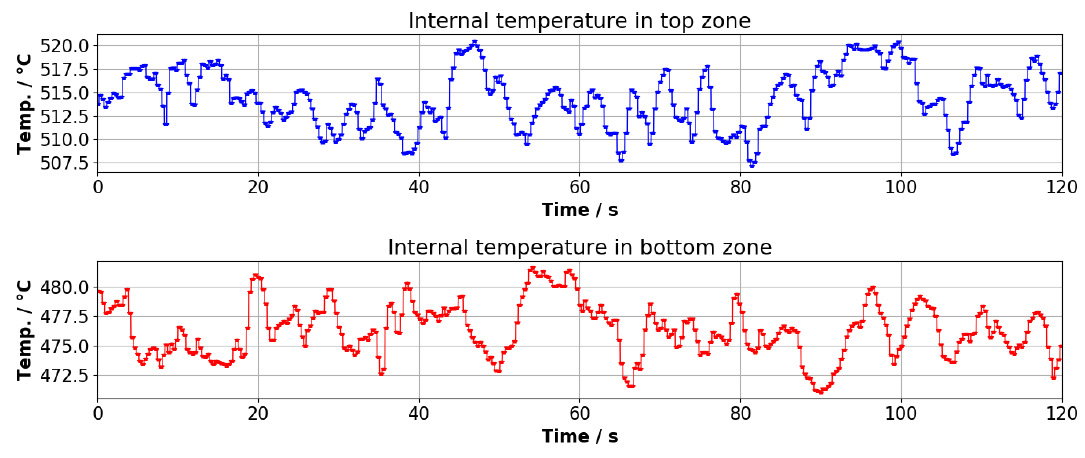
Figure 6. Internal temperature data recorded with a time resolution of 10 ms at quasi-steady state during experiment B for dissolution zone ( top ) and crystallization zone ( bottom ).